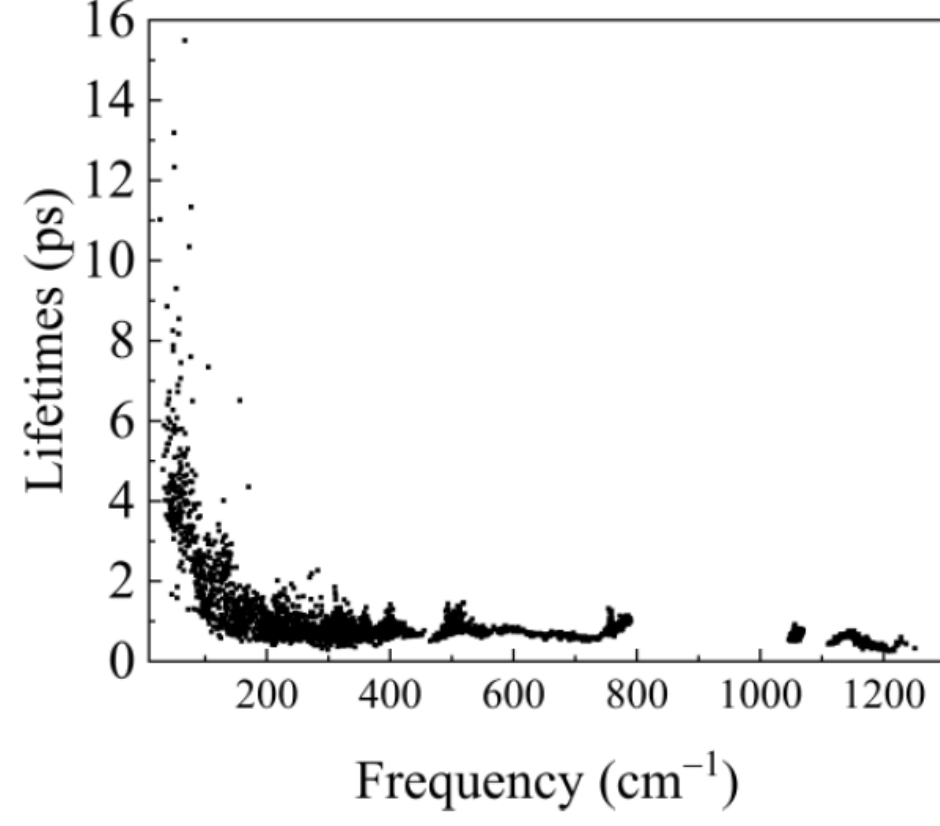
Figure 5. The phonon lifetimes due to the phonon–phonon cubic interaction at 300 K. Then, we used the phonon propagator algorithm to calculate the VDOS with the phonon lifetimes and frequency correction. Although the cubic interaction contributes little to the main peak of the low frequency part, the effects of the cubic interaction are important. The cubic anharmonic interaction can lead the frequency of the peak shifts to lower frequency as shown in Figure 6a. In addition, it is noticed that the shift of frequency mainly appears at the low-frequency part. Due to the limited lifetimes, there is a slight change on the shape of the low-frequency part of the VDOS. Furthermore, if the cubic anharmonic interaction is strong, i.e., phonon–phonon scattering is strong [43–45], the frequency of the peak may be overestimated without the cubic anharmonic interaction. These calculation results identify the role of the cubic anharmonic interaction for the VDOS. It is seen in Figure 6b that the peak is predominantly contributed from TA phonon branches, while the Longitude Acoustic (LA) branch contributes a little to the peak. This result agrees well with the analysis of the harmonic phonon. Moreover, we checked the error of the calculation data. The experiment at room temperature shows that the frequency of the peak is about 7.06 meV [39]. However, our calculation result at 300 K is about 8.92 meV. The lattice parameters in our calculation are 5.103 and 7.135 angstrom, which are different from the experiment value 4.978 and 6.948 angstrom [39]. Due to the different lattice parameters, the error can be